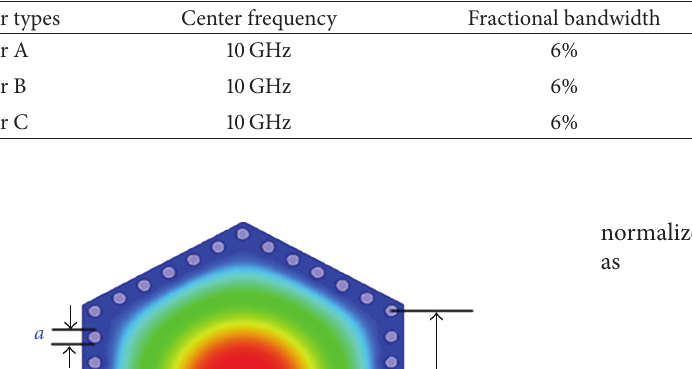
Table 1: Design goal of filters A, B, and C.